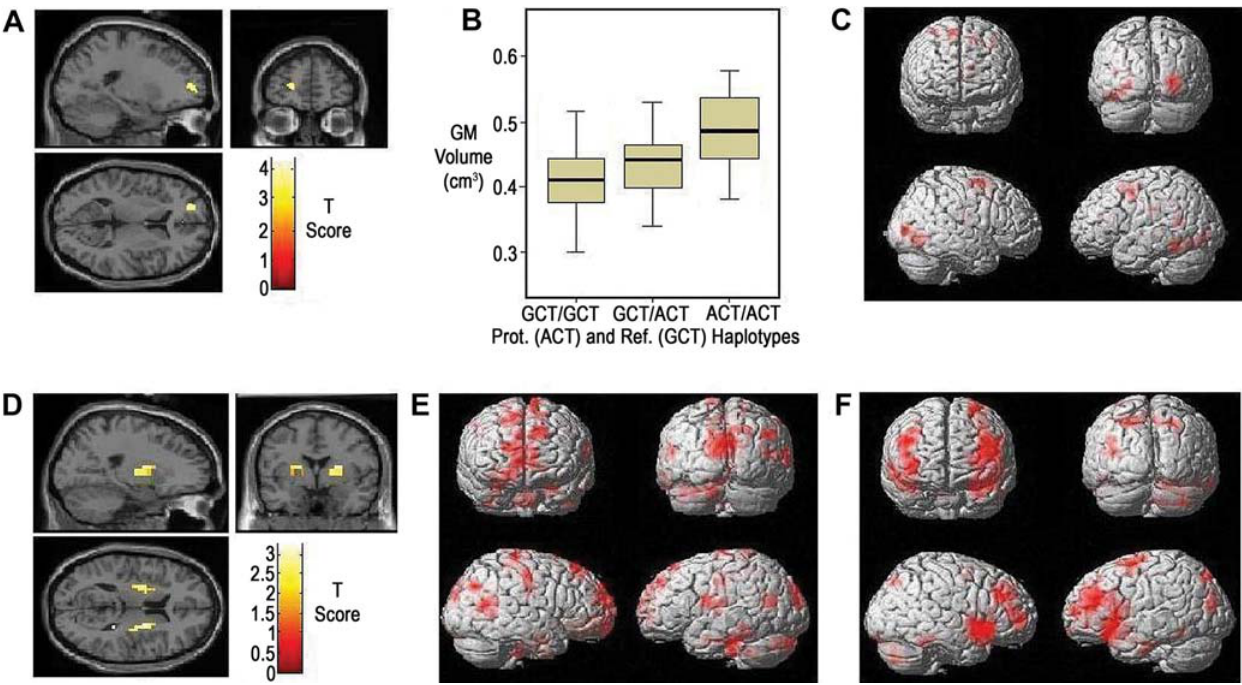
Figure 3. Protective and reference haplotypes: multimodal imaging results (see supplemental tables for results surviving multiple comparison correction). A) Increases in grey matter volume for protective haplotype carriers in relationship to reference haplotype at p , 0.001 uncorrected threshold. B) Extracted values of cluster grey matter for left frontal lobe at threshold of p , 0.001 as a function of protective haplotype. C) Relatively decreased BOLD signal of early sensory processing stream for protective haplotype carriers on the working memory network in normal subjects at FDR , 0.047 full brain corrected. D) Decreased BOLD signal for protective haplotype carriers in relationship to reference haplotype, at p , 0.05 uncorrected threshold within Caudate and Putamen as defined by the Wake Forest University brain atlas. Areas of relatively E) increased and F) decreased connectivity for protective haplotype effect at uncorrected threshold of p , 0.05. Statistical mappings are overlaid on a single subject T1 images. Statistical results after multiple comparison correction shown in Tables S1, S2 and